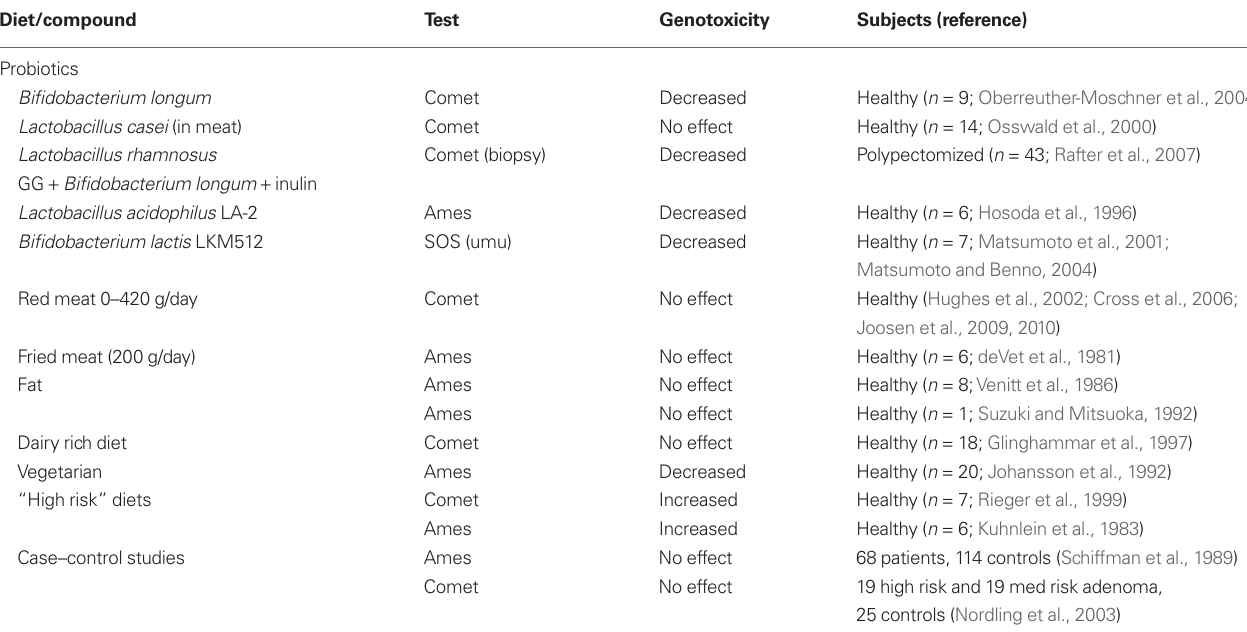
Table 1 | Summary of dietary studies assessing genotoxicity in human fecal